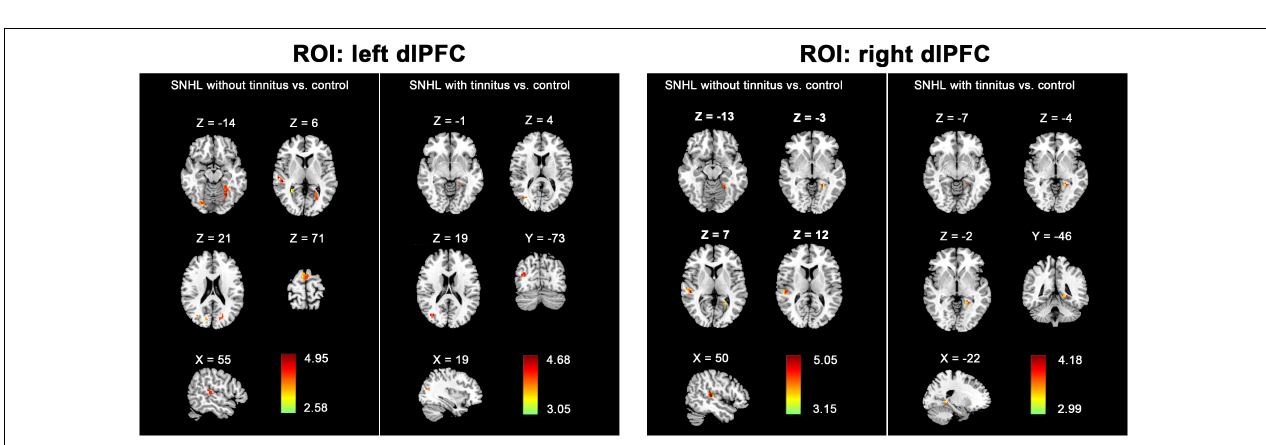
FIGURE 4 | The between-group difference distribution map of FC with the seed set to the left and right dlPFC among the SNHL without tinnitus, SNHL with tinnitus, and healthy controls, independent of age, sex, or education ( p < 0.05/3, corrected by FDR). Significantly increased FC is present in the red-yellow heat scales. The color bars show the t scores obtained from the between-group